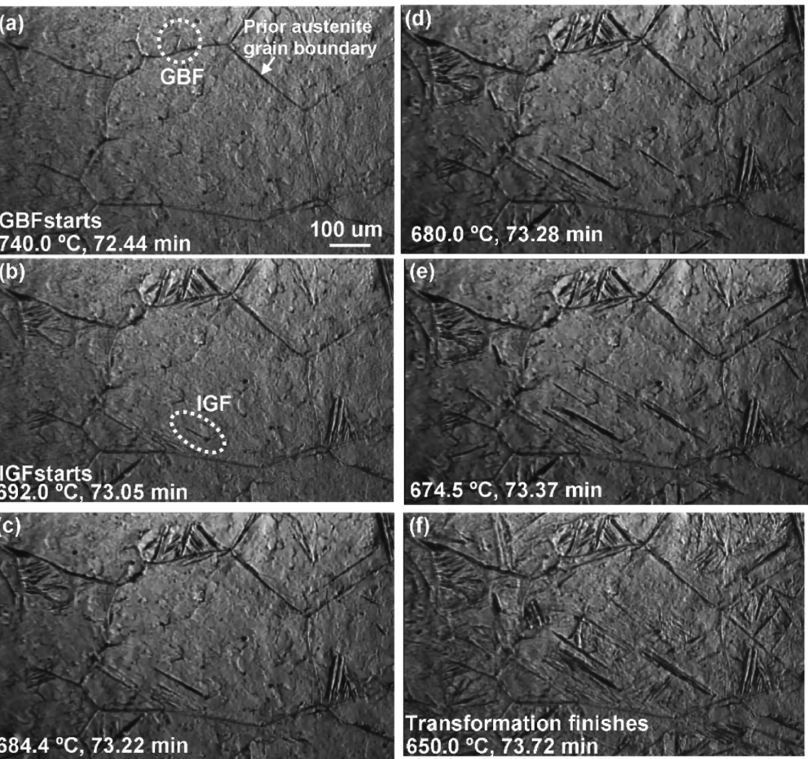
Figure 15: Images observed by confocal laser scanning microscopy (CLSM) for GBF and IGF formation with holding con- dition of 1400°C × 0min and cooling rate of 70°C/min [10,